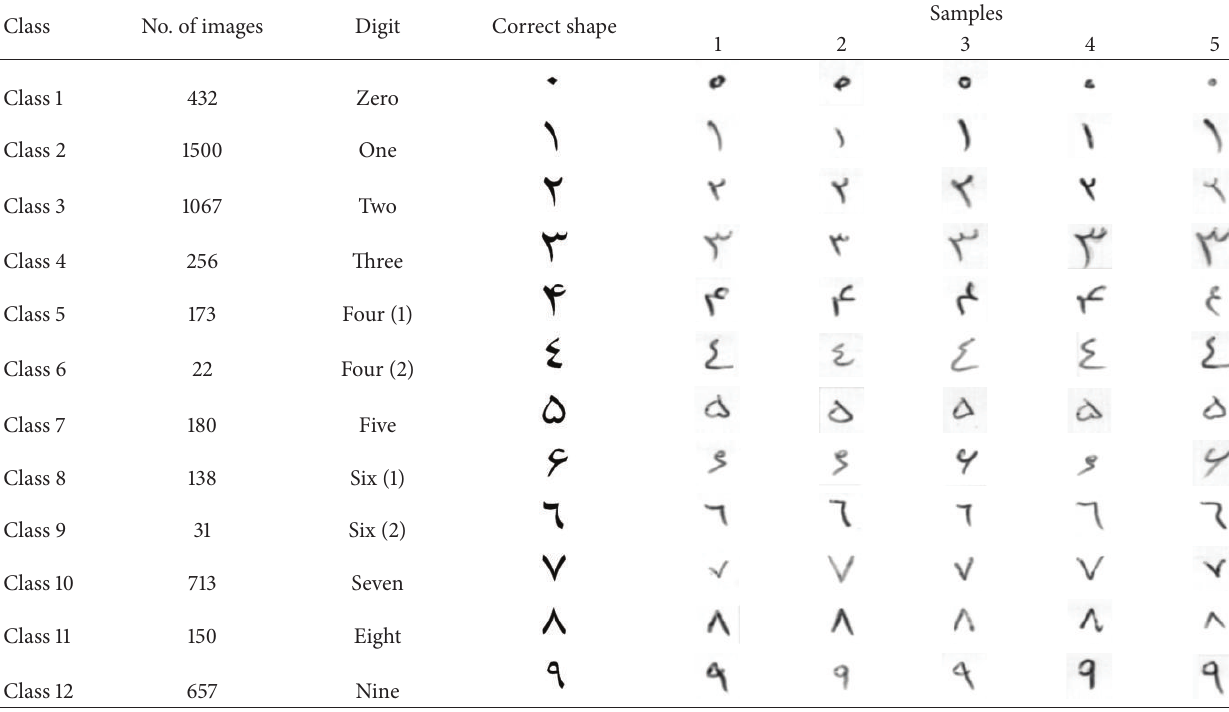
Table 3: Some samples of handwritten Persian digit